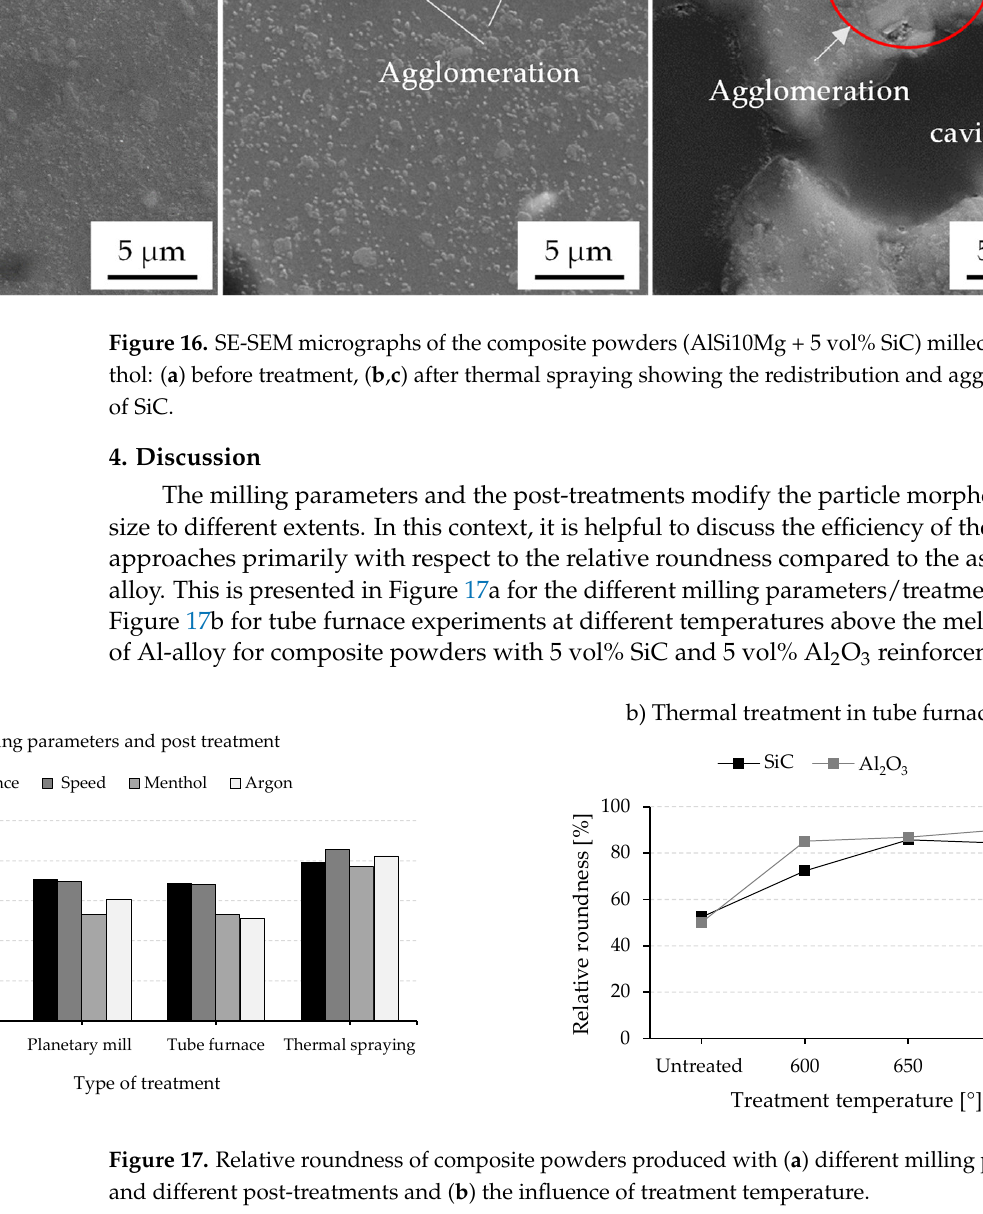
Figure 17. Relative roundness of composite powders produced with ( a ) different milling parameters and different post-treatments and ( b ) the influence of treatment temperature.